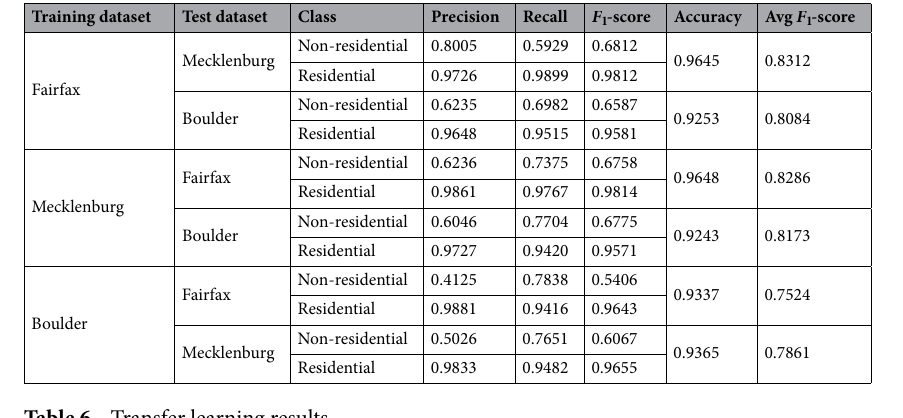
Table 6. Transfer learning